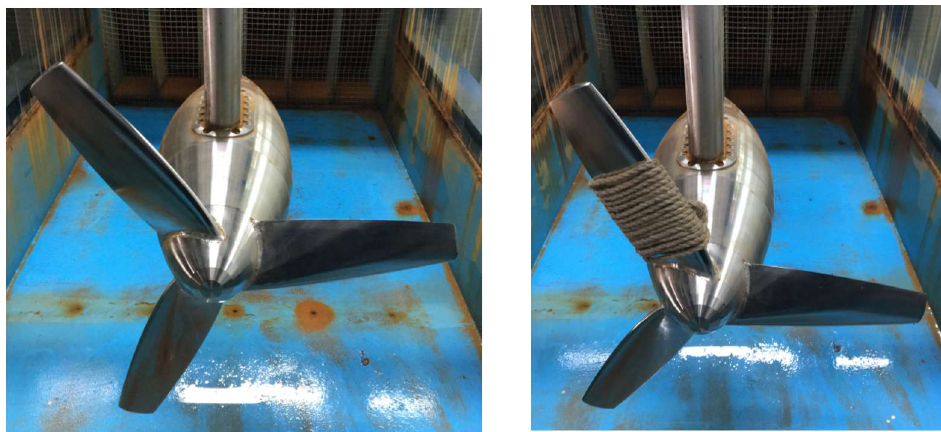
Figure 10. Imbalance fault (biofouling emulation) setting: healthy blade ( left ), imbalanced blade with 144 g attachment ( right ).